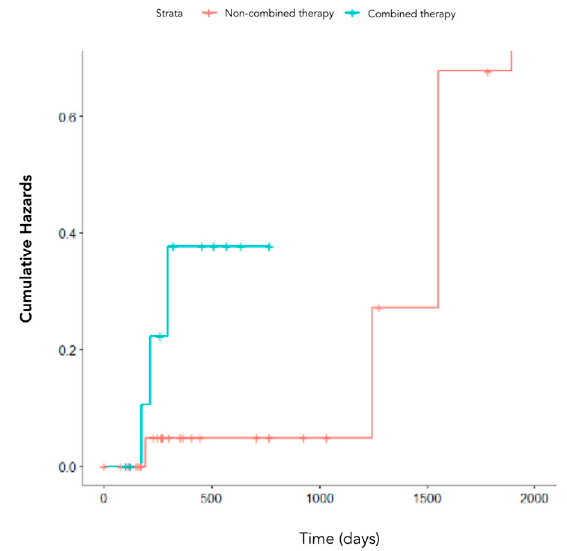
Figure 8. Kaplan–Meier cumulative hazards of patients stratified according to the combination of treatments, i.e., patients who underwent one (blue curve) or more than one therapy type (red curve). The type of therapy was not significant ( p -value = 0.9), as highlighted in Figure 9.